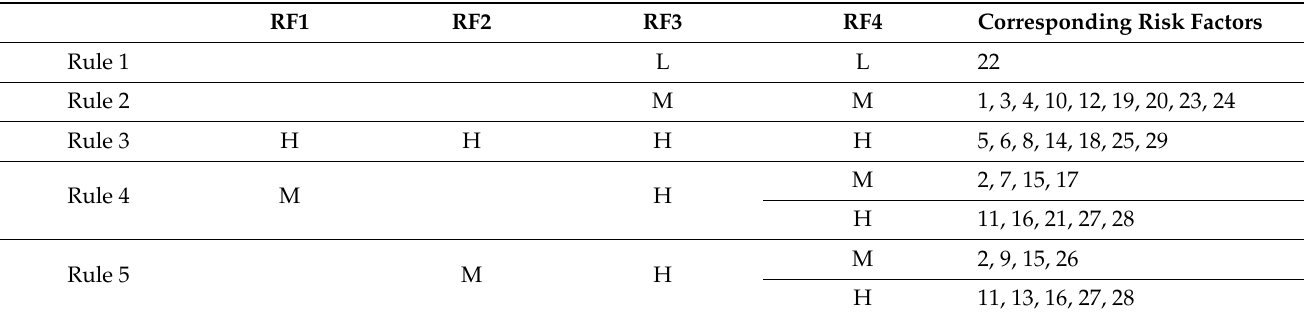
Table 5. The calculated results by